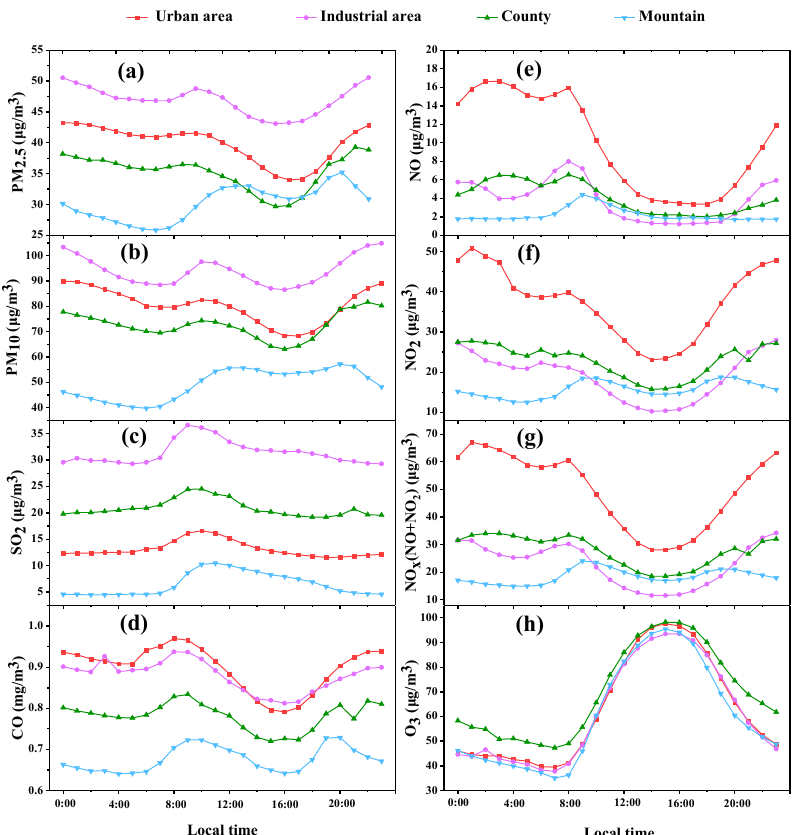
Figure 5. Time mean concentrations of air pollutants: ( a ) PM 2.5 ; ( b ) PM 10 ; ( c ) SO 2 ; ( d ) CO; ( e ) NO; ( f ) NO 2 ; ( g ) NOx (NO + NO 2 ); ( h ) O 3 .